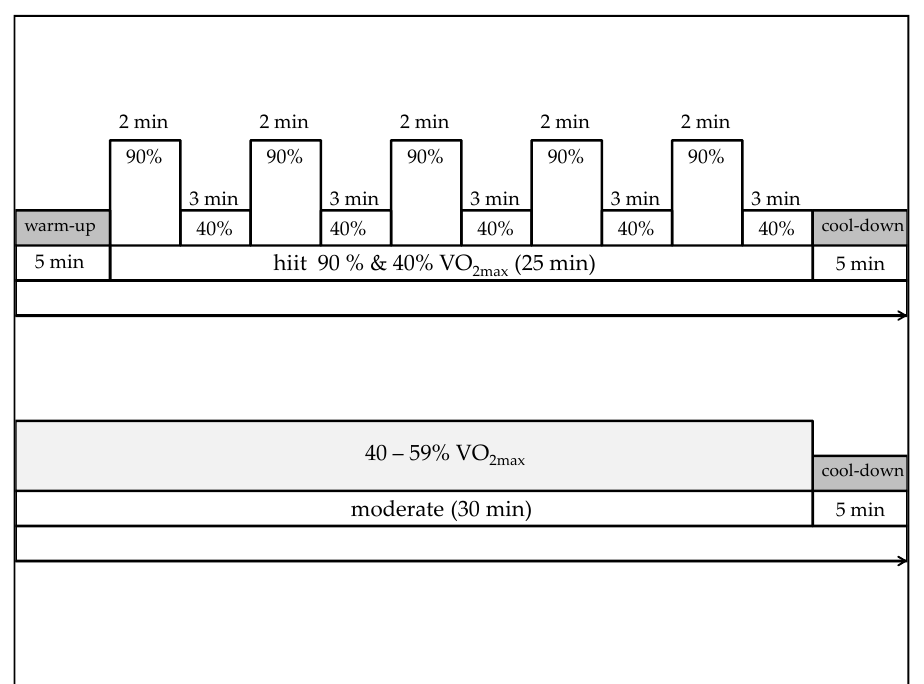
Figure 2. Both physical exercise conditions lasted 35 min each. Single session physical exercise in moderate intensity: 30 min at 40–59% VO 2max and 5 min warm up at 40% VO 2max . Single session high intensity interval training (hiit): 5 min warm up at 40% VO 2max , 5 two-minute periods at 90% VO 2max each followed by three-minute recovery periods at 40% VO 2max and a cool down at 40% VO 2max .